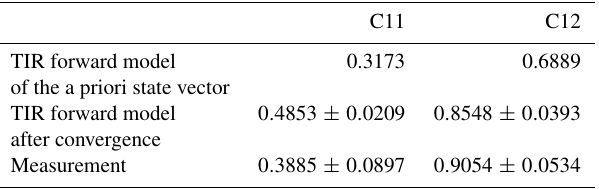
Table 1. TIR forward model and measured normalized radiances Table 2. TIR forward model and measured normalized